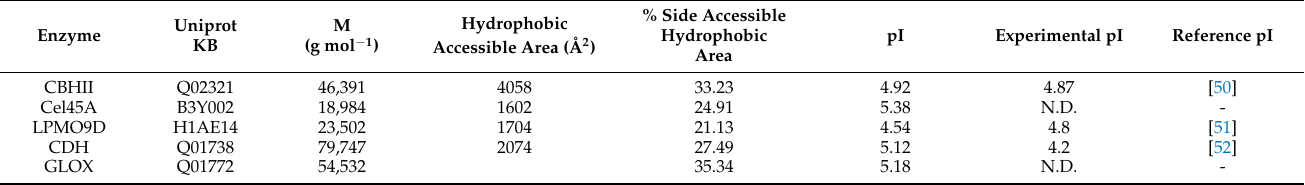
Table 3. Hydrolases and oxidoreductase physicochemical properties computed using protein se- quences and protein structures. For GLOX, an AlphaFold prediction model was constructed from the protein sequence. N.D., not